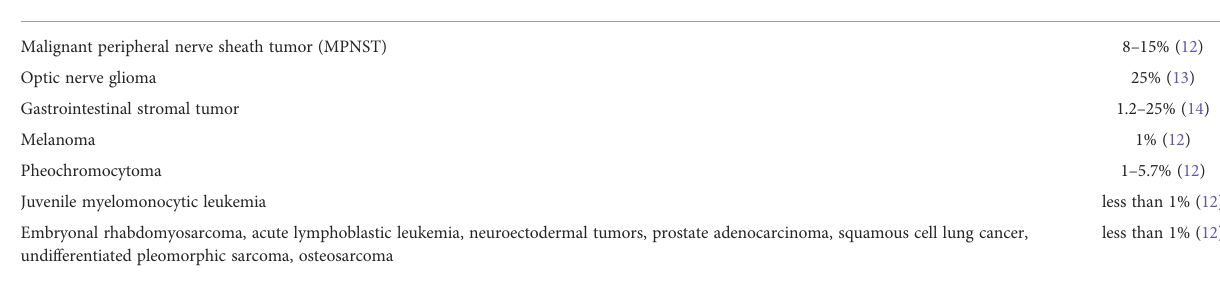
TABLE 1 The incidence of malignant neoplasms in patients with